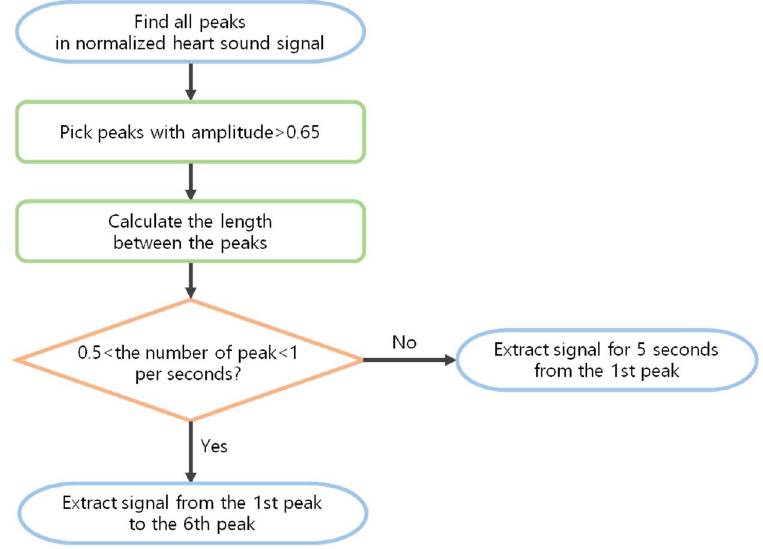
Figure 5. Flow chart for making a constant length of data.